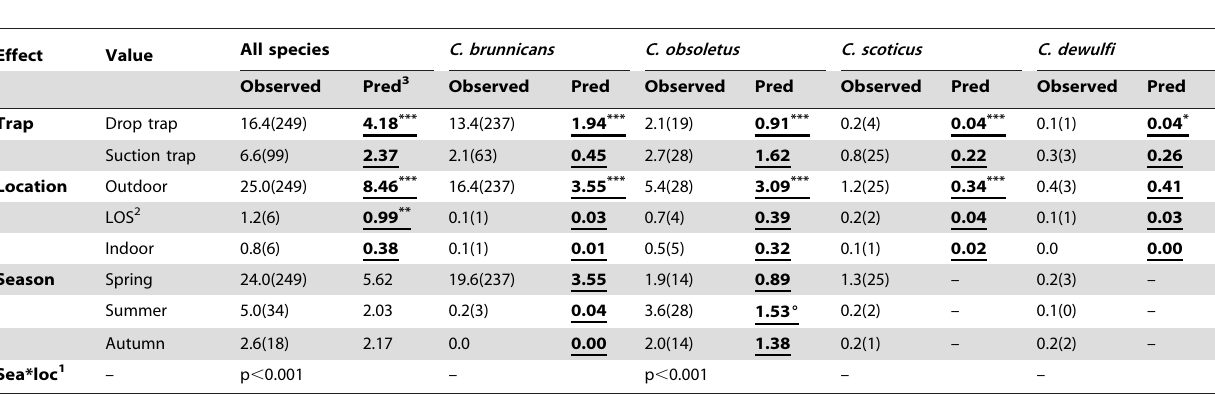
Table 2. Mean No. observed (max) and predicted Culicoides for all species and the most abundant species depending on the trap, the location and the season.